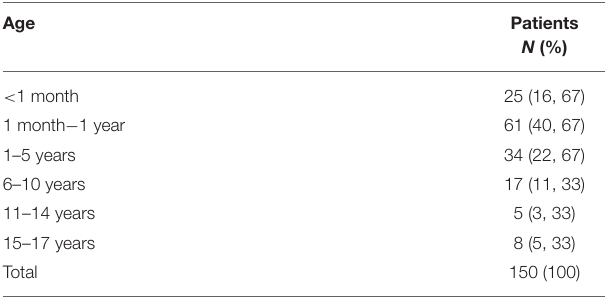
TABLE 4 | Distribution of the pediatric patients by